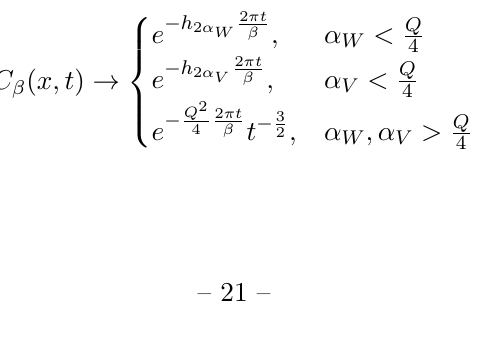
Figure 10 . Left: (blue) the late-time value of TOMI in the scaling limit grows logarithmically with k (3.49). Right: k = 1 ; 10 ; 20 from bottom to top. Saturation occurs around k f g before which, there is sublinear growth. When subsystem size overcomes the size of the local Hilbert space size, the TOMI